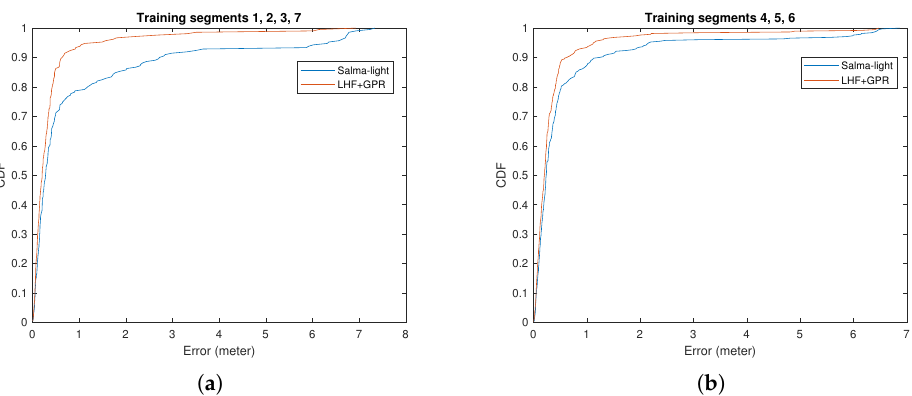
Figure 12. CDF of the localization error using ( a ) training segments 1, 2, 3, 7, ( b ) training segments 4, 5, 6. The blue solid line plots the error CDF obtained when SALMA-light is used. The orange solid line plots the error CDF obtained when optimizing the LLHF with prior knowledge from GPR. The phase ζ k is approximated by using the phase from CIR. Visibility test is carried out, followed by overlap checking, before implementing the